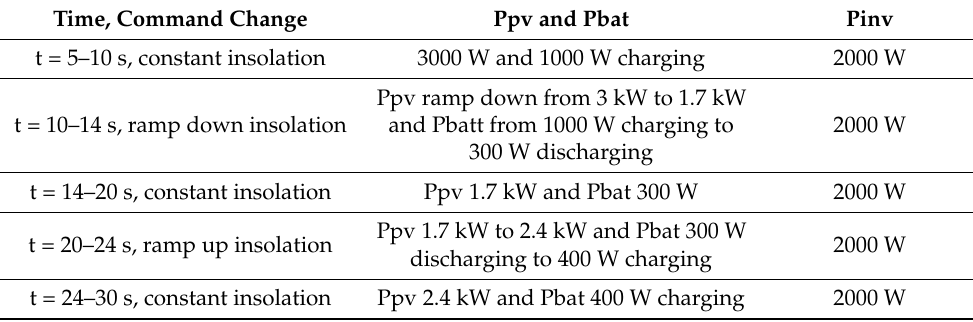
Table 4. Insolation-change